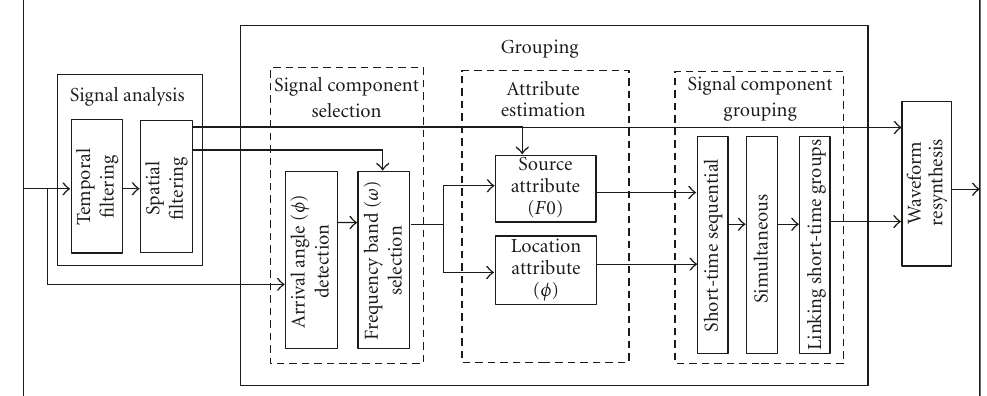
Figure 1: Block diagram of CASA-EB.